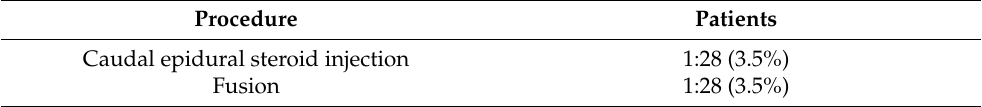
Table 5. Patients who underwent further